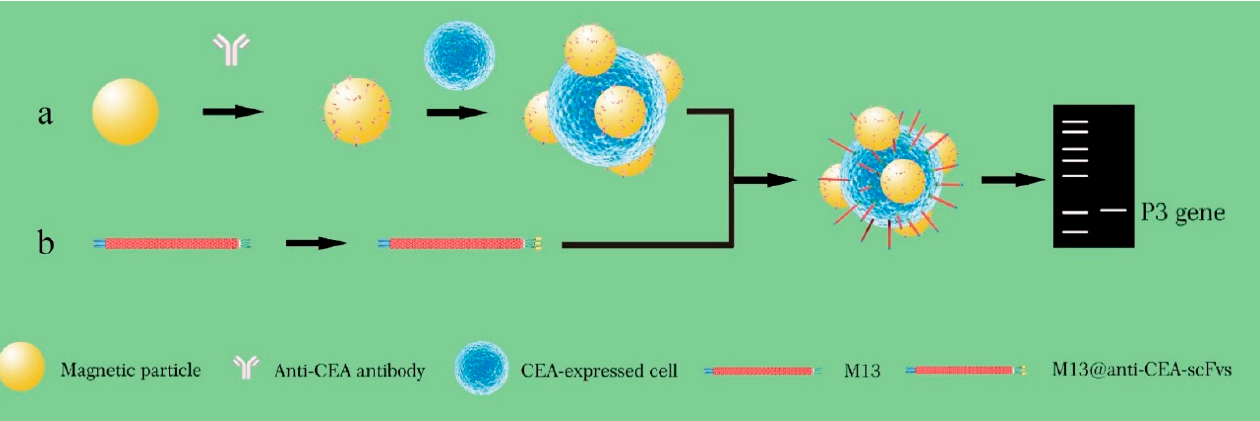
Figure 9. Detection of CEA-expressed cells using M13KO7-ACEA scFv phage (Cited from 62). ( a ) Magnetic nanoparticle (MNP) probes were prepared by mixing MNPs with anti-CEA (carcinoembryonic antigen) antibodies, followed by separation with magnetic power and washing three times. The MNP probes were first used for pulling down CEA overexpressed CTC in the blood sample and subjected to binding by M13 probes to form the sandwich complexes. ( b ) The M13 phage with p3 displaying anti-CEA scFv was constructed using the pCANTAB-5E-anti-CEA scFv plasmid. The plasmids were transformed into E. coli TG1 cells and then the cells were infected with M13KO7 helper phages. After 2 h, the recombinant M13@anti-CE-scFvs were purified from the E. coli TG1